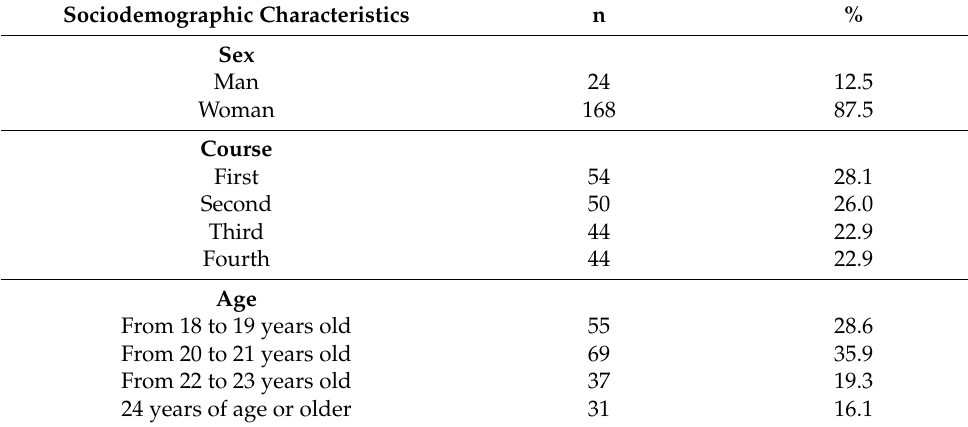
Table 1. Sociodemographic characteristics of the participants (n = 192).